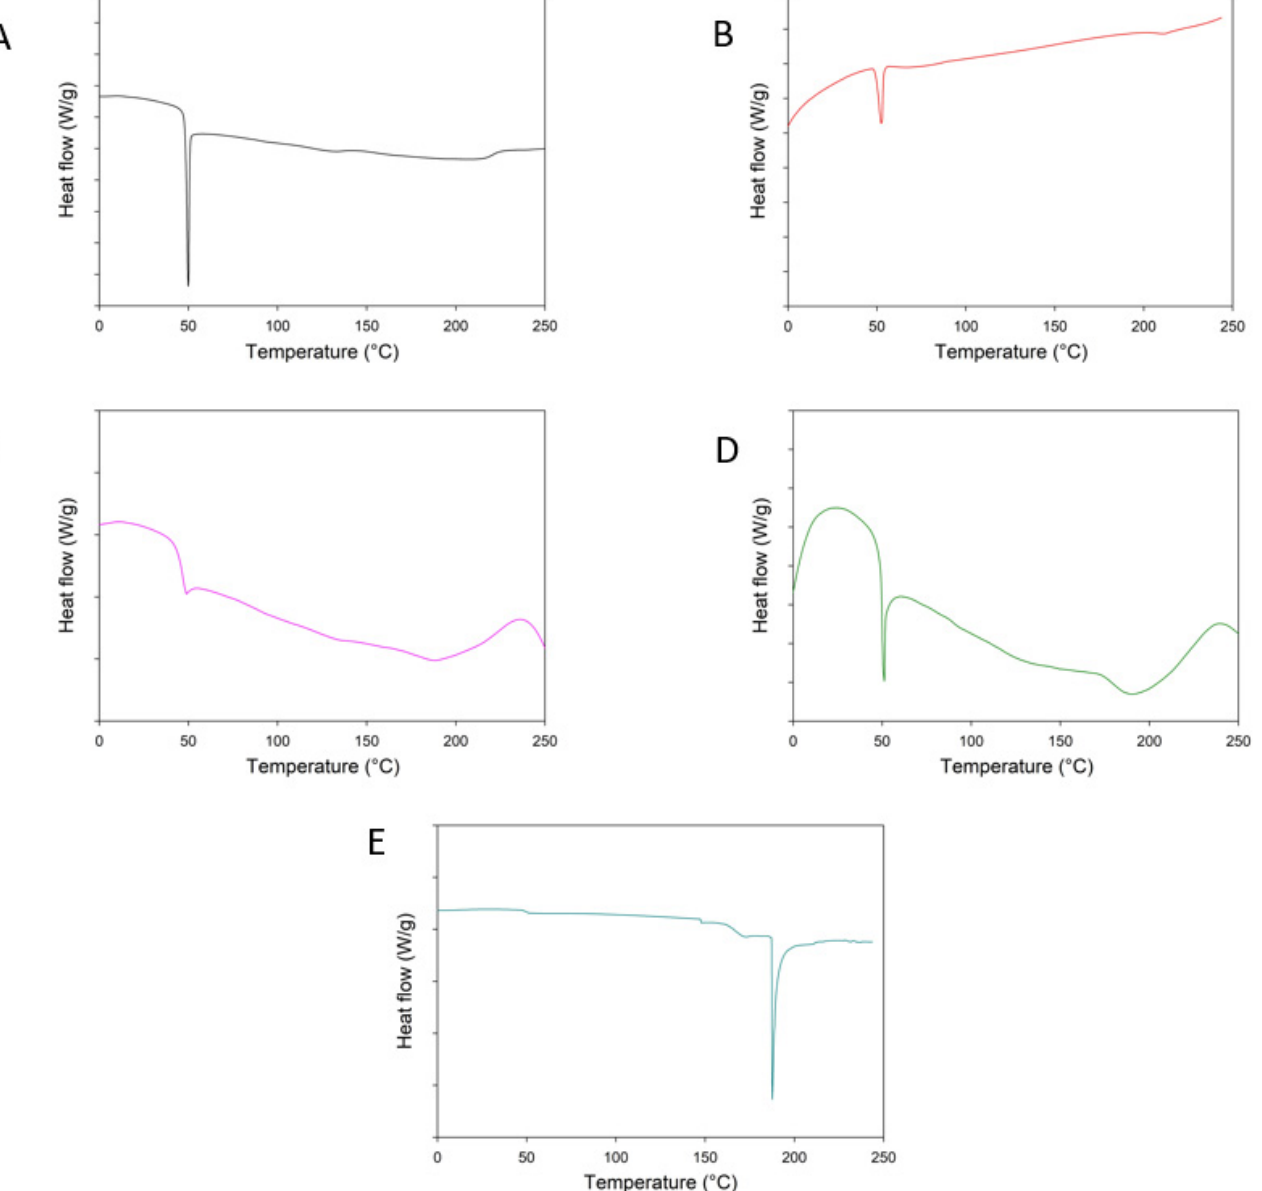
Figure 3. Differential scanning calorimetry (DSC) curves of Raw PNA5 glycopeptide and formula- tions: ( A ): 503 NPs, ( B ): 503H NPs, ( C ): 503 MPs, ( D ): 503H MPs, ( E ): Raw PNA5.